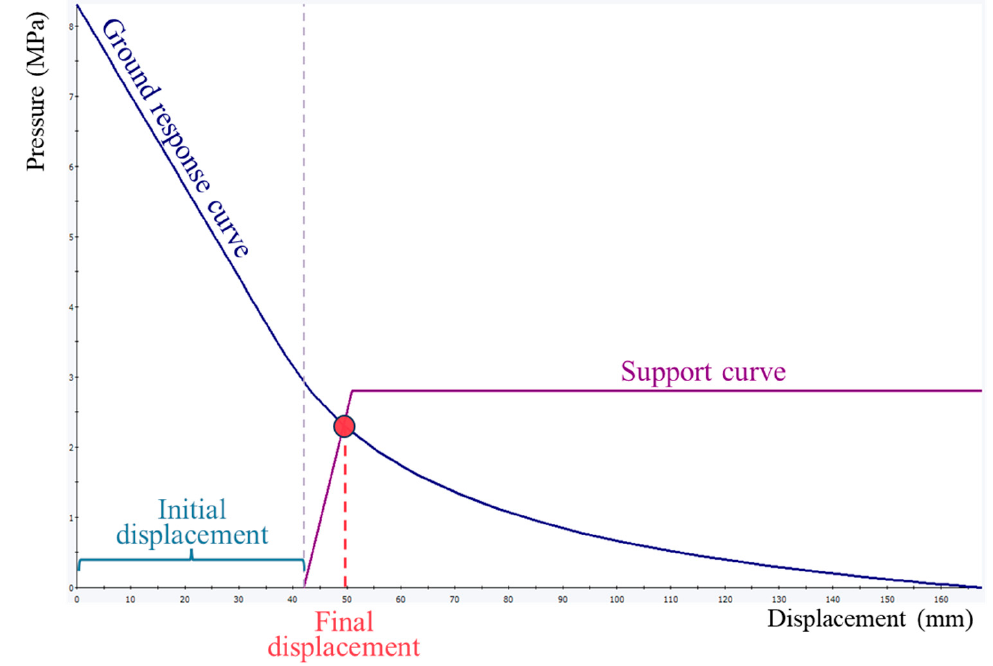
Figure 3. Example of CC plot generated via the program RocSupport.